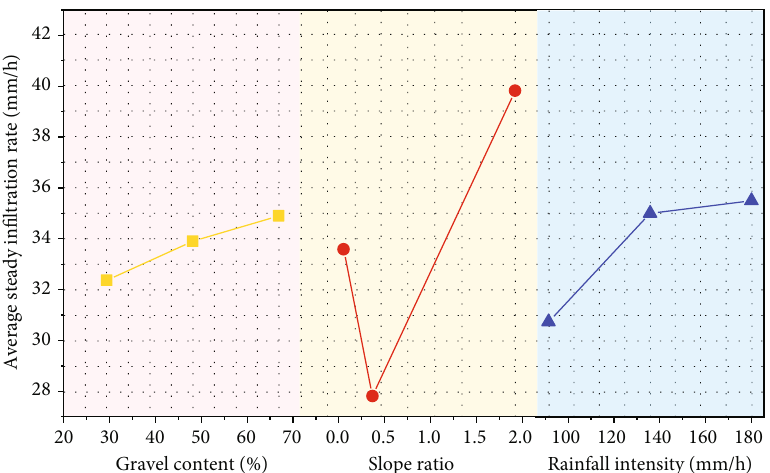
Figure 11: Relationship between the average steady in fi ltration rate and gravel content, slope ratio, and rainfall intensity.